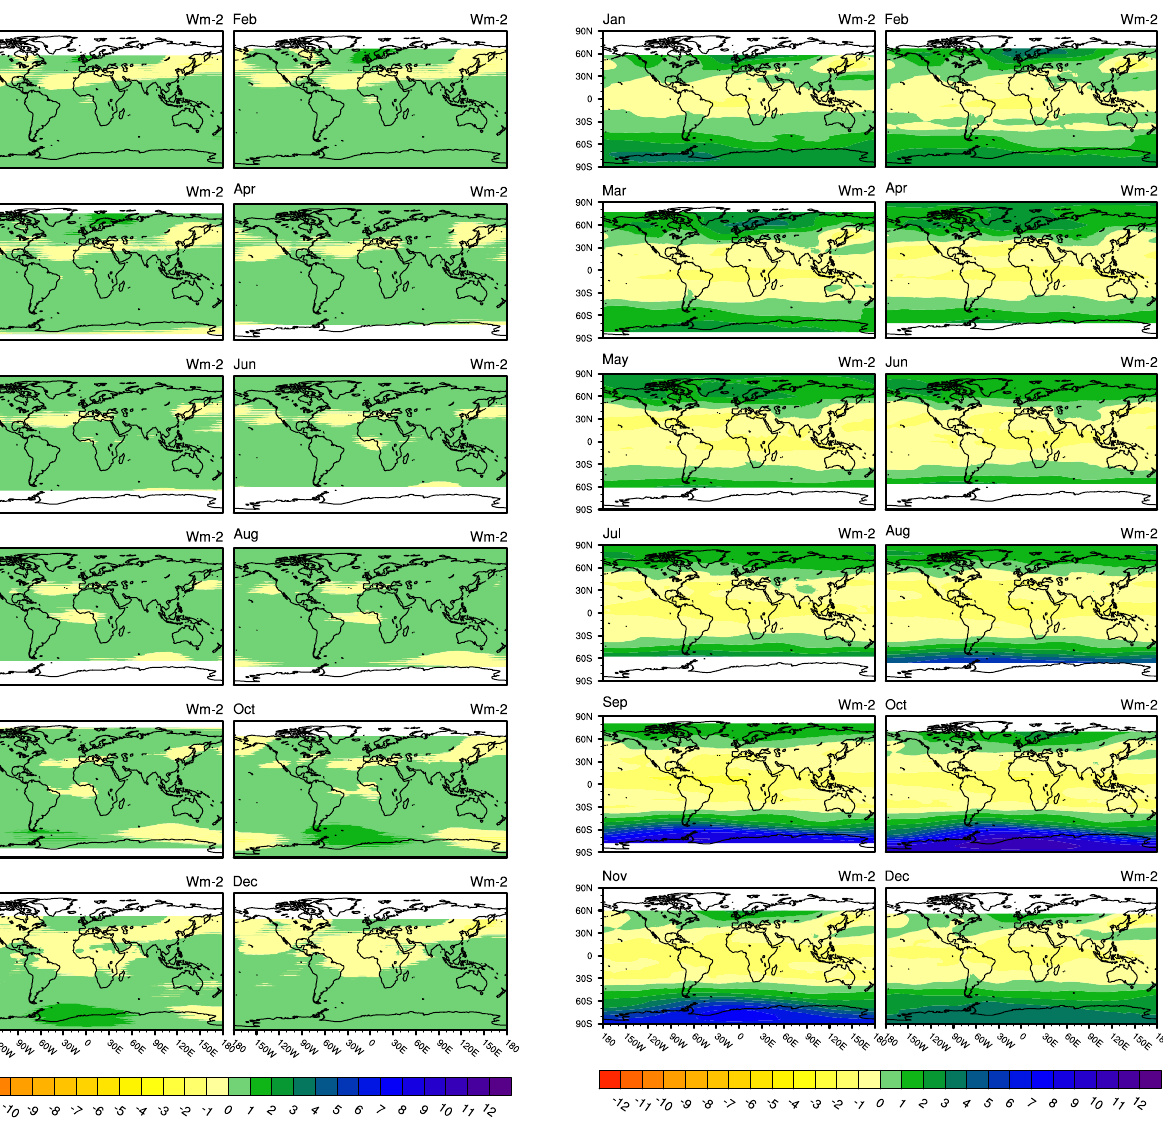
Figure 9. Bias in the ozone absorption using the MSR monthly av- erages for the period (1979–2008) as a baseline for CAM.